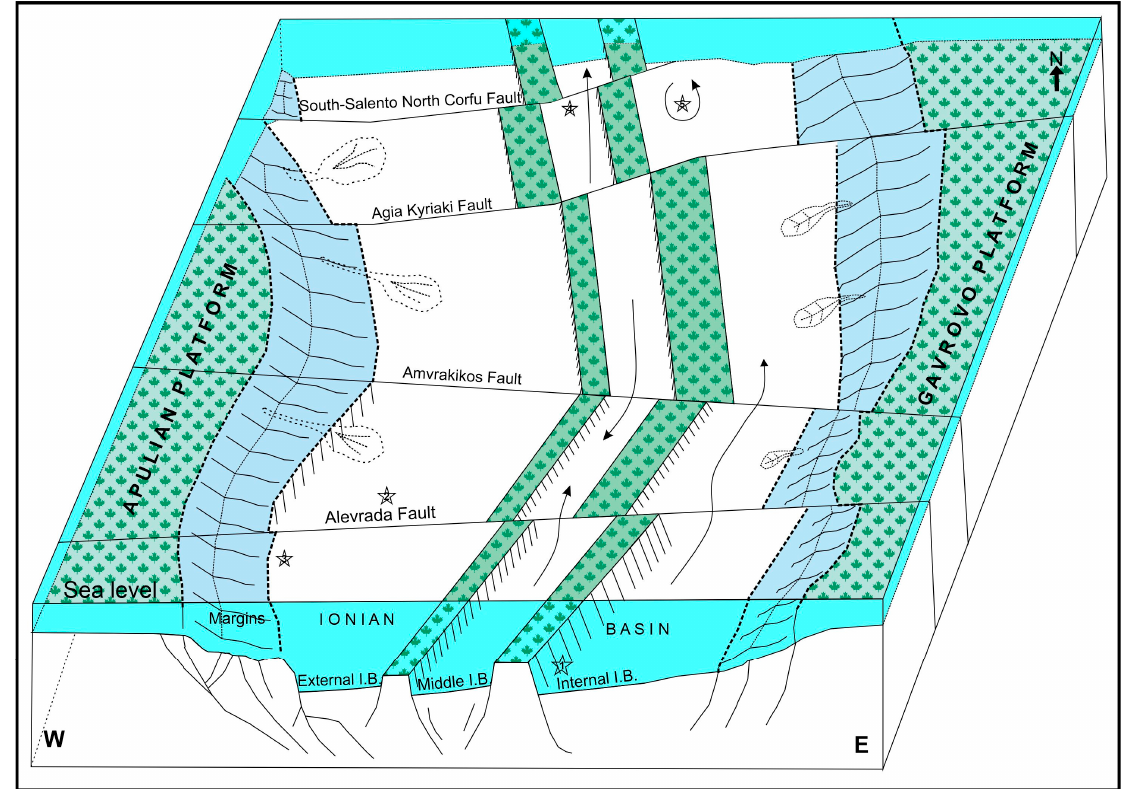
Figure 11 . Schematic block diagram (not to scale) showing the influence of synsedimentary normal and transfer faults activity on basin configuration during Lower Cretaceous accumulation of “Vigla” shales. Stars with numbers inside show the positions of studied areas. Number 1—Araxos peninsula, 2—Kastos island, 3—Ithaca Island, 4—Gotzikas section, and 5—Ioannina well.